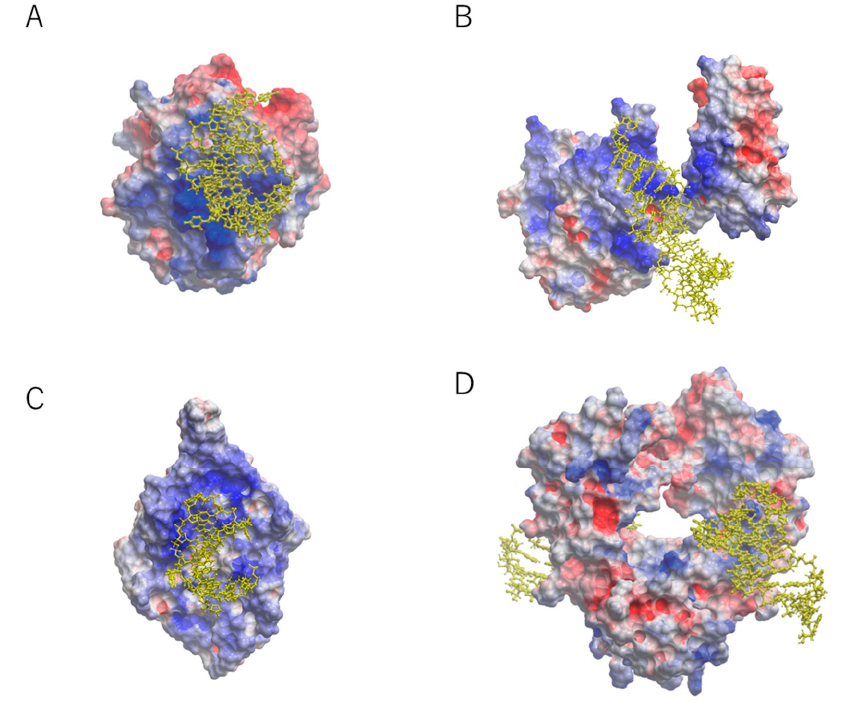
Figure 1. Overall structure of known aptamer–protein complexes with electrostatic surface potential [5]. The RNA aptamer is represented by a yellow ball-and-stick model. ( A ) Aptamer–thrombin complex at 1.8 Å resolution [13]. ( B ) Aptamer–nuclear factor- κ B complex at 2.45 Å resolution [11]. ( C ) Aptamer–MS2 coat protein complex at 2.8 Å resolution [12]. ( D ) Aptamer–Fc region of human IgG1 (hFc1) complex at 2.15 Å resolution [16]. Blue areas: positively charged; red areas: negatively charged.